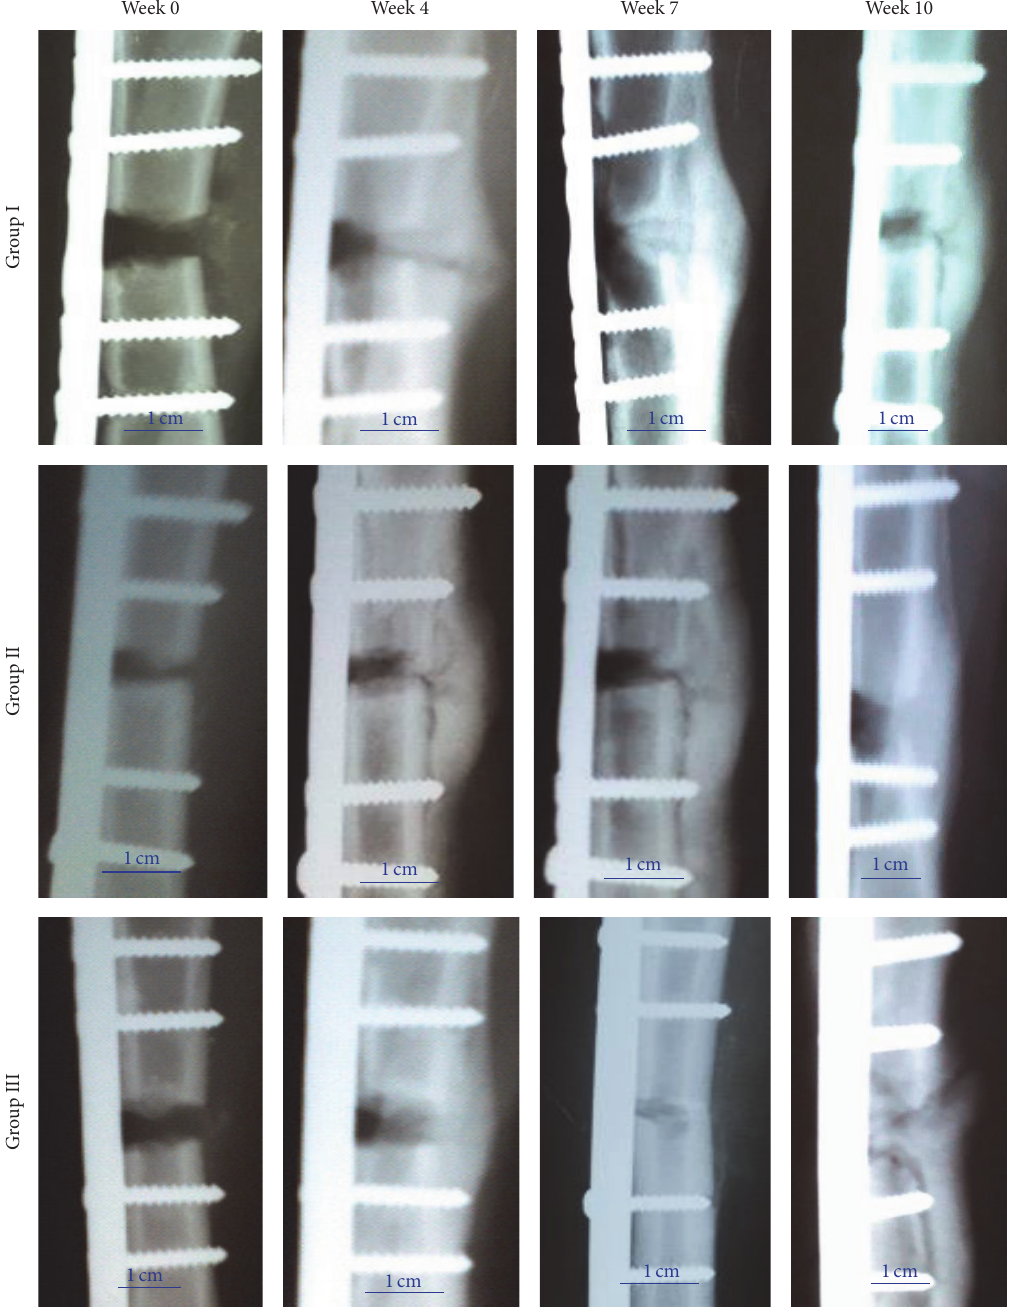
Figure 4: Radiographic followup at 0 to 10 weeks of treatment groups: Group I, control without an implant; Group II, implant with a DBM seeded with MSCs without transduction; and Group III, implant with a DBM and MSCs transduced with AdBMP2/AdBMP7. Scale bar: 1 cm.